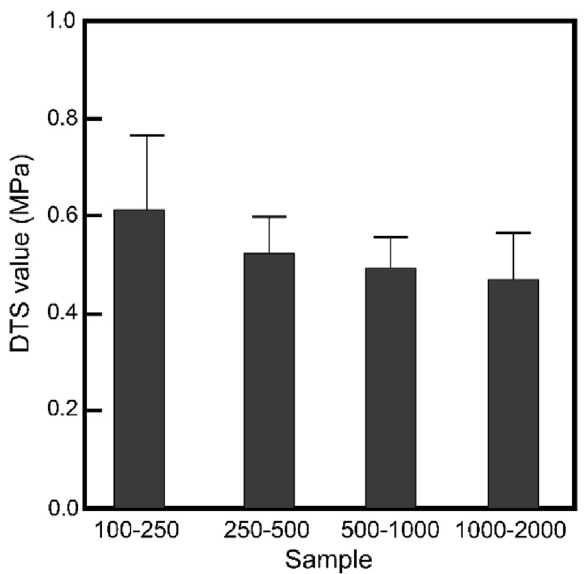
Fig. 6 DTS values obtained for the OCP-Ag foams as a function of initial granule sizes